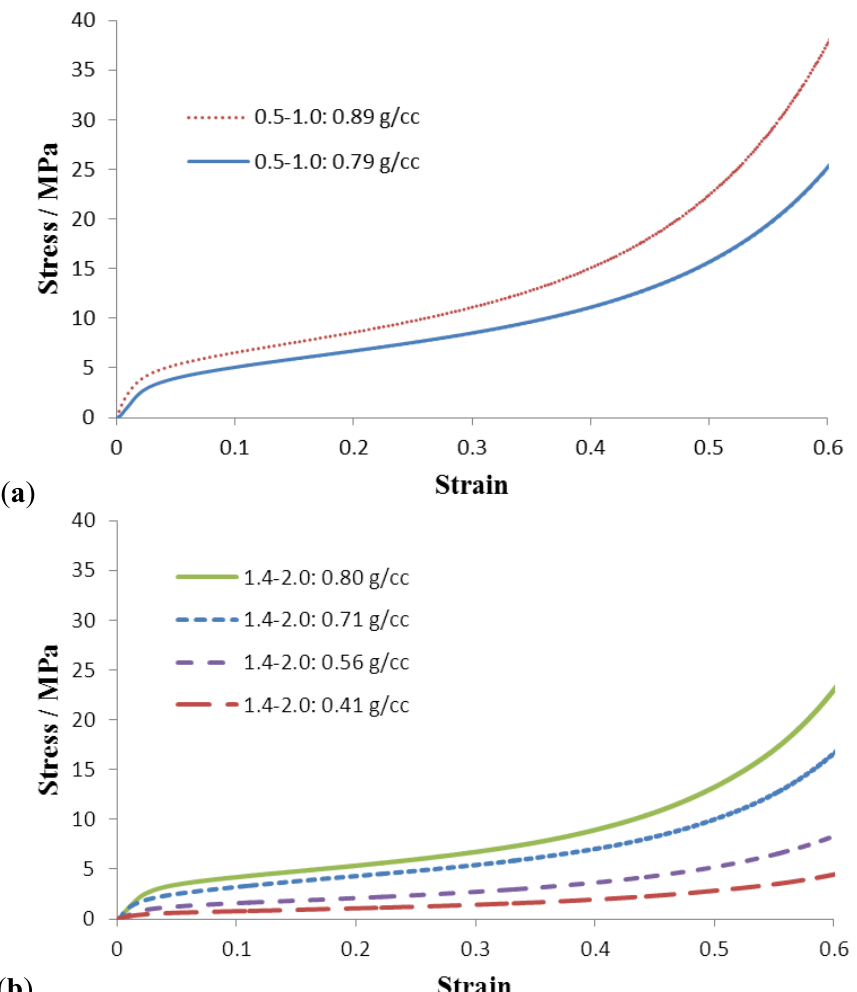
Figure 6. Compressive stress-strain curves for porous Al made from different